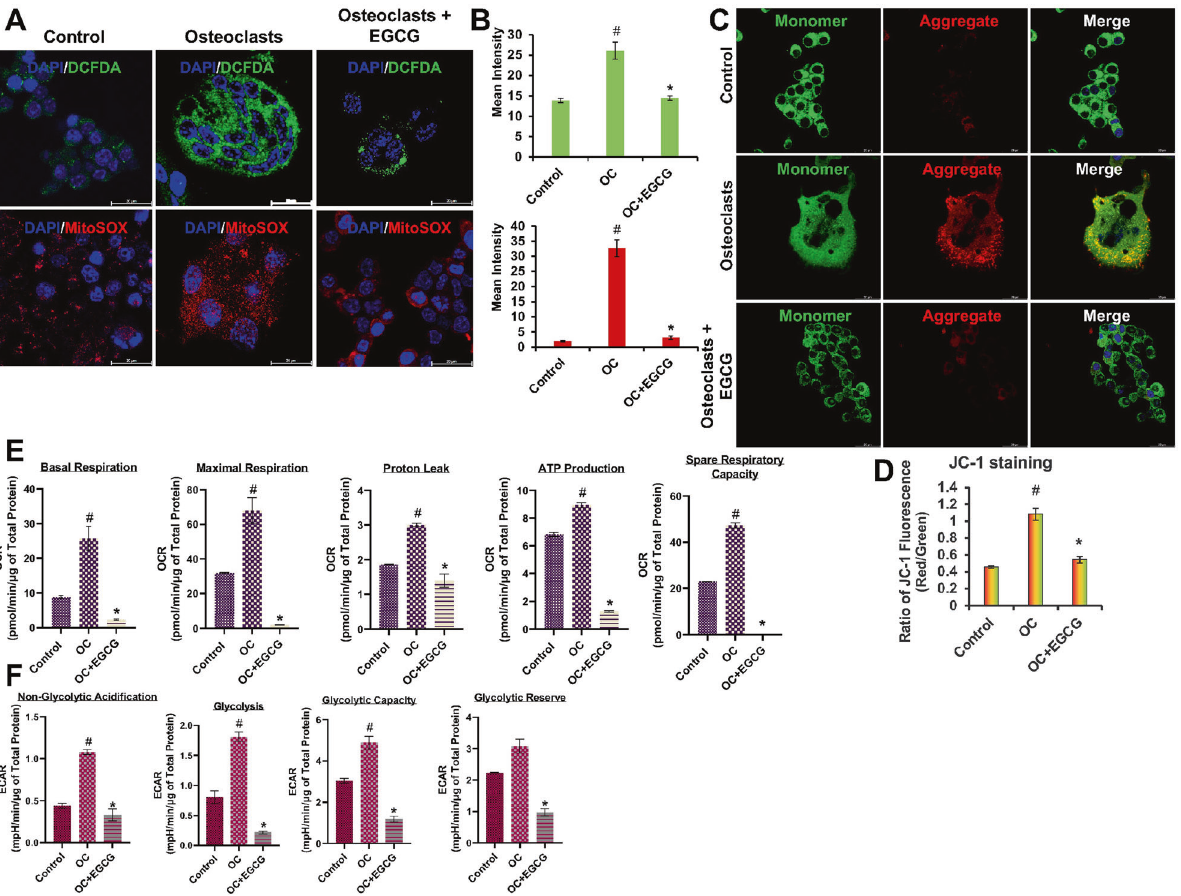
Fig. 2 EGCG inhibits ROS production, mitochondrial membrane potential and improves the mitochondrial functional activity during OC differentiation. A ROS generation was detected by DCFDA and mitoSOX staining. B Quanti fi cation graph for mean fl uorescence intensity (green for DCFDA and red for mitoSOX staining). C JC-1 staining for mitochondrial membrane potential measurement. D Quanti fi cation of membrane potential by measuring the ratio of red and green fl uorescence intensity graph. Seahorse fl ux analysis results are